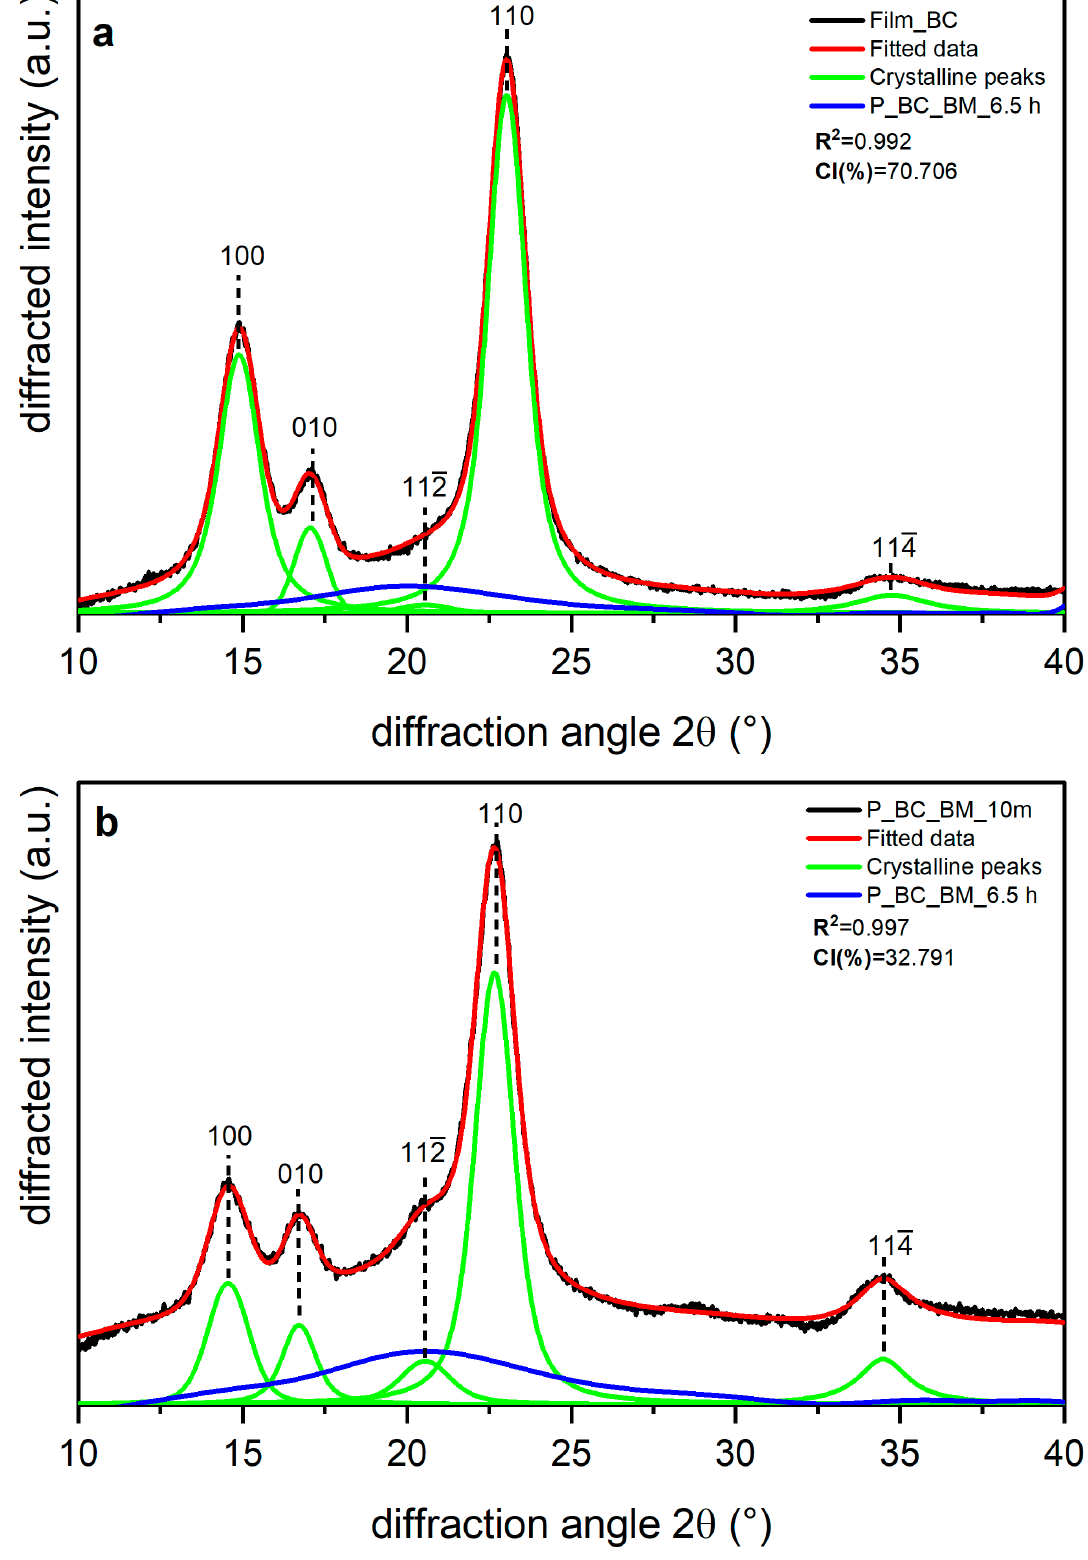
Figure 7. X-ray diffraction spectra recorded from bacterial cellulose (BC): ( a ) unmilled (film BC), and ( b ) milled for 10 min (P_BC_BM_10 m) and 6.5 h (P_BC_BM_6.5 h). The indexation is that defined in [40].